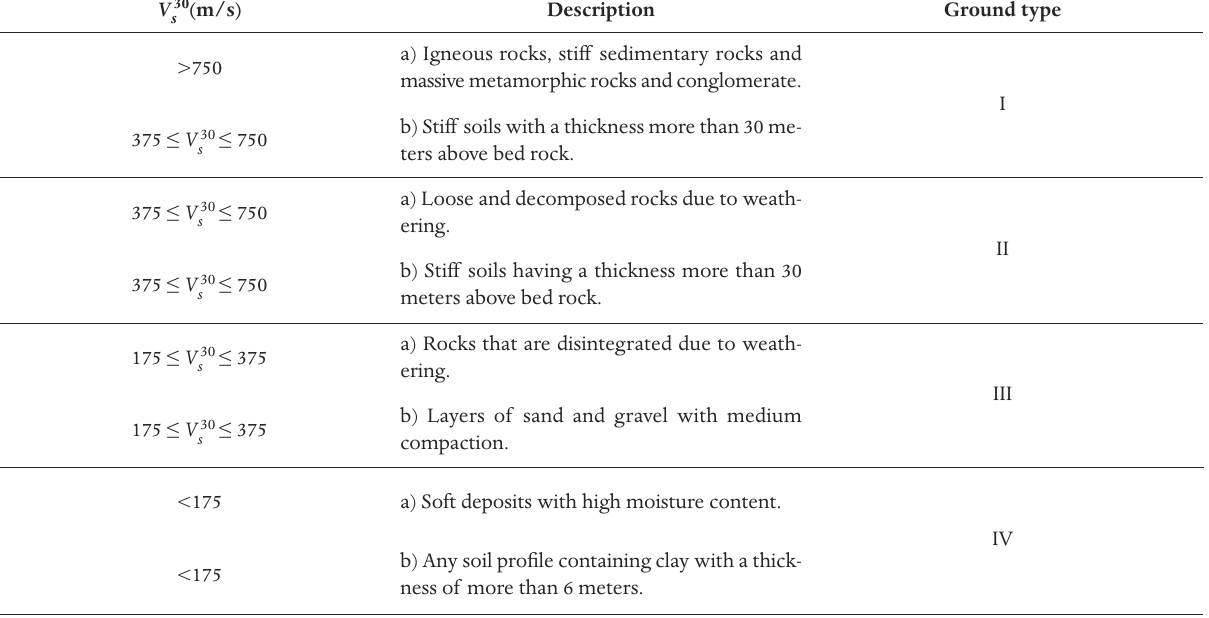
30 is V averaged over the top 30 m of s s